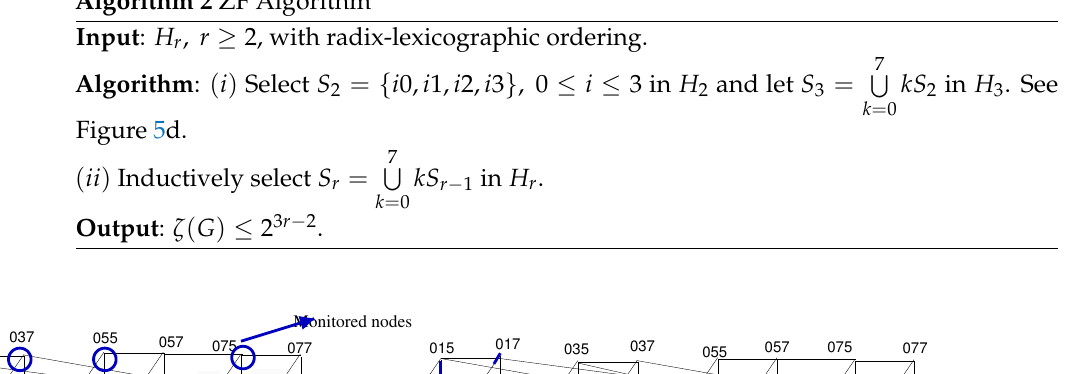
Algorithm 2 ZF Algorithm